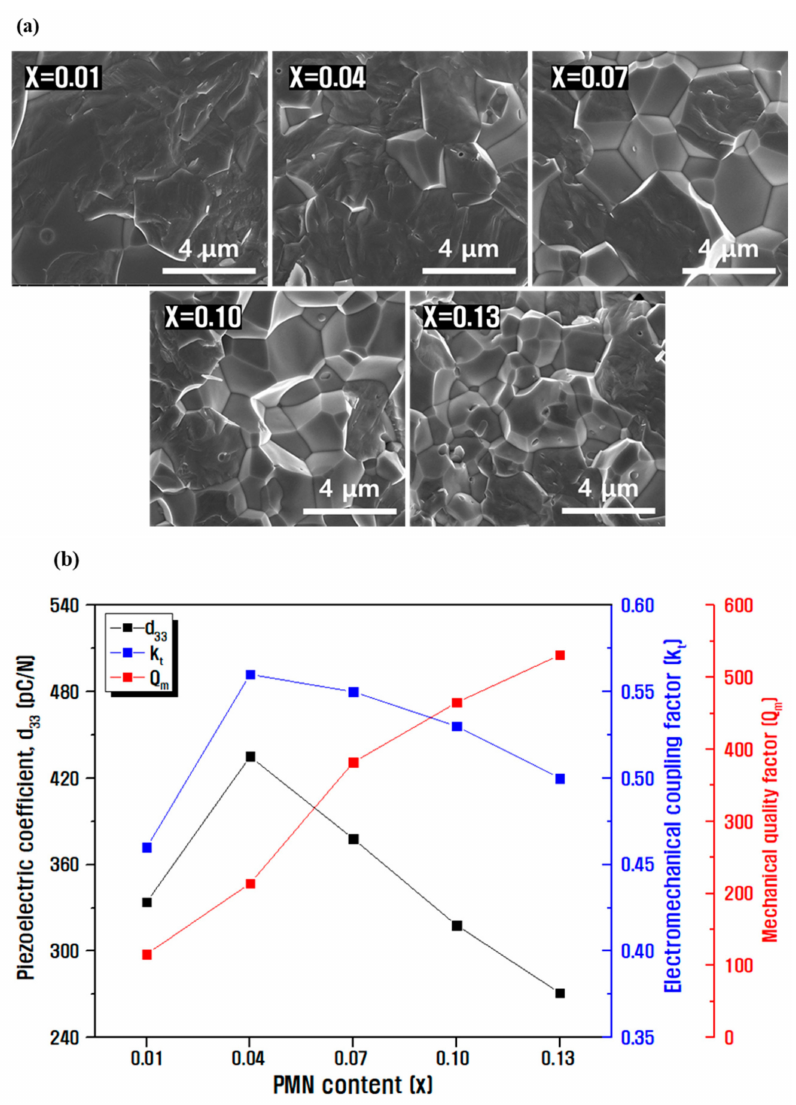
Figure 2. ( a ) FE-SEM images of fracture surfaces with different PMN molar ratios and ( b ) measurement results of electrical properties in (0.15-x)Pb(Ni 1/3 Nb 2/3 )O 3 -xPb(Mn 1/3 Nb 2/3 )O 3 -0.85Pb(Zr 0.5 Ti 0.5 )O 3